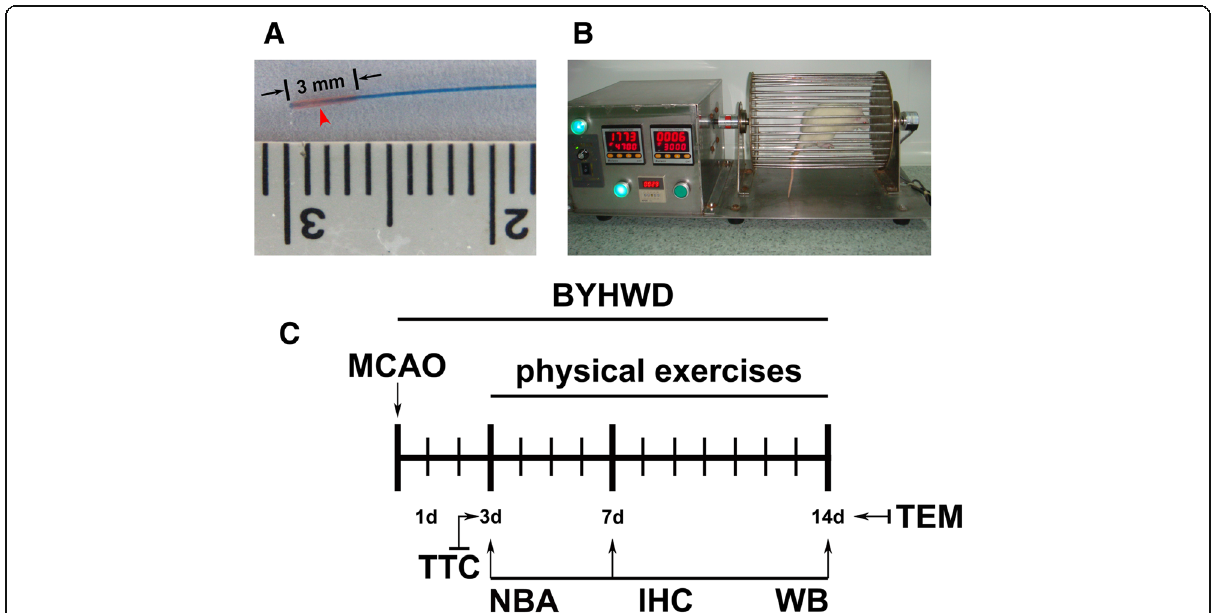
Fig. 1 Laboratory techniques used in this study. A 4 – 0 suture coated with silicone rubber ( a ) was used for the MCAO induction. A programmable and motorized running wheel apparatus ( b ) was employed for the physical exercises post-cerebral ischemia. The design of this study ( c ). The intragastric administration of BYHWD began 2 h after the MCAO induction and was administered daily from Day 1 to 14 or until euthanasia. The physical exercises began on Day 3 post-ischemia and ended on Day 14 or euthanasia. The analytic modalities (neurobehavioral assessment, immunohistochemistry, and western blot) were performed on Day 3, 7 and 14 after the MCAO induction. Other techniques (TTC and TEM) were performed on Day 3 or 14 after the MCAO induction. BYHWD, Buyang Huanwu decoction; IHC, immunohistochemistry; MCAO, middle cerebral artery occlusion; NBA, neurobehavioral assessment; TEM, transmission electron microscope; TTC, triphenyltetrazolium chloride staining; WB, western-blot